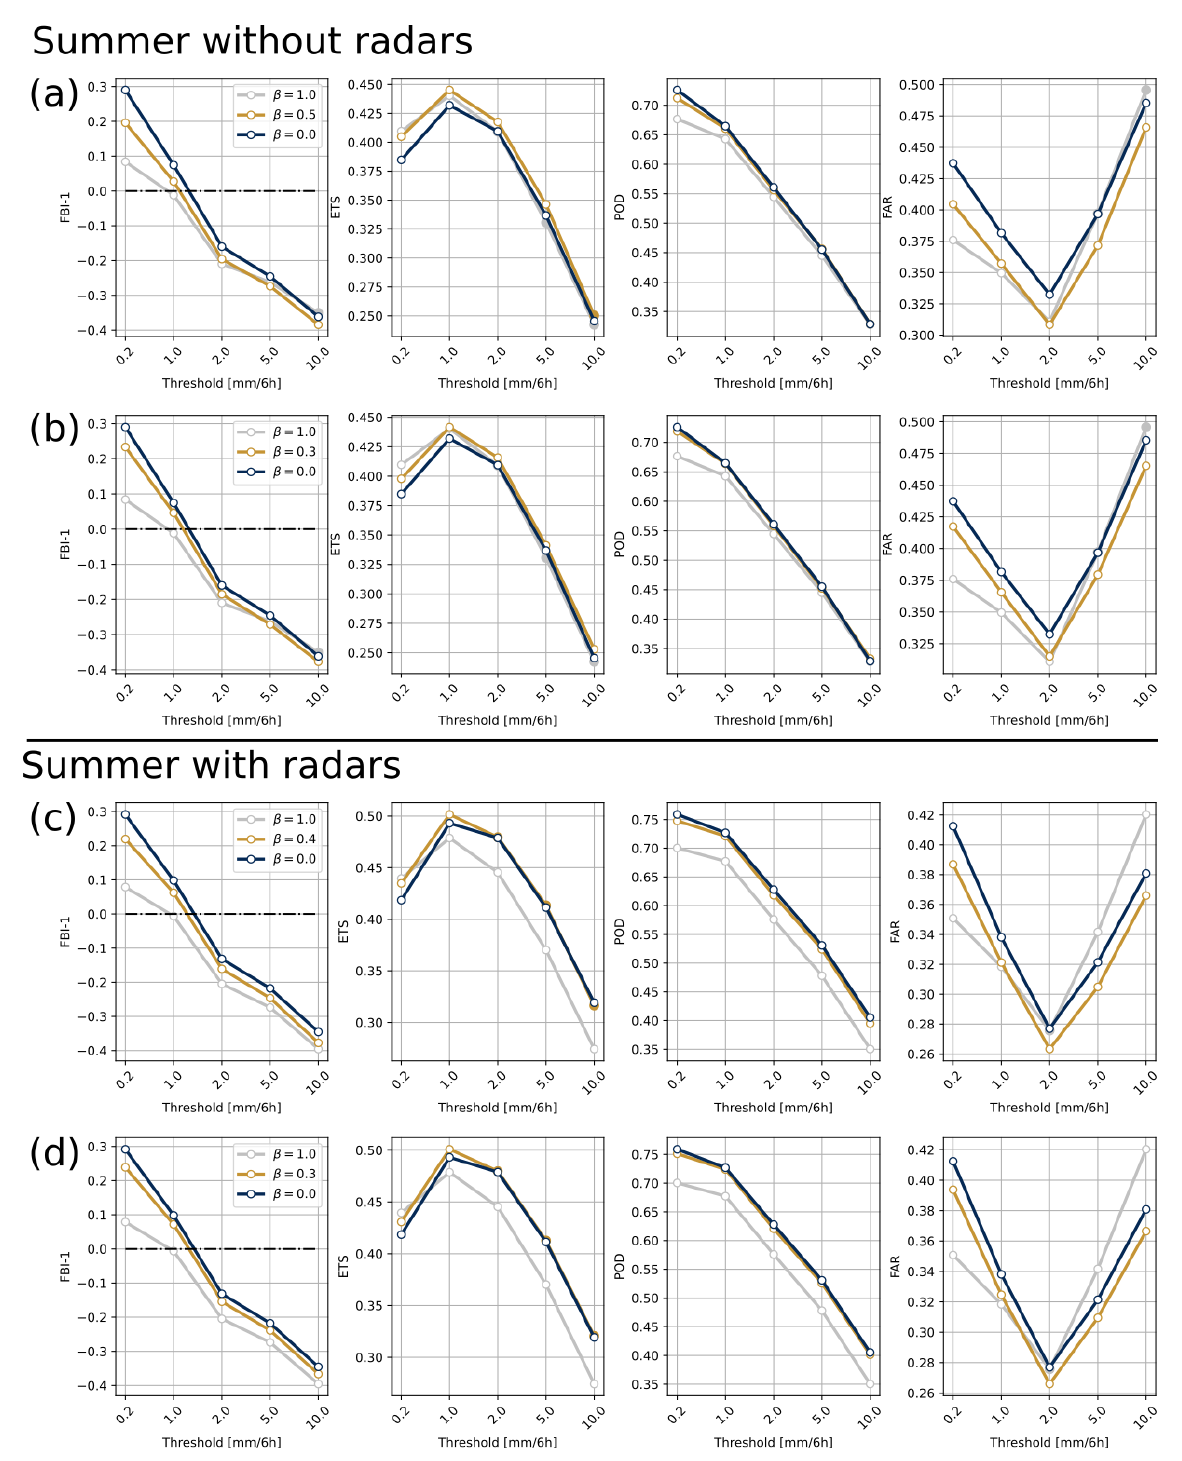
Figure 3. Panels (a) and (b) show the FBI-1, ETS, POD, and FAR across the whole domain for the summer experiment without radar QPEs for precipitation analysis with β = 0 . 0 (dark blue line), β = 1 . 0 (gray line), β = 0 . 5 (yellow lines in a ), and β = 0 . 3 (yellow lines in b ). Panels (c) and (d) are the same figures but for the summer experiment with the assimilation of radar QPEs with β = 1 . 0 (gray lines), β = 0 . 4 (yellow lines in c ), and β = 0 . 3 (yellow lines in d ), with all three compared to the reference experiment when β = 0 . 0 (blue lines). Filled markers indicate no significant differences (at the 95% confidence level) between the reference experiment β = 0 . 0 and the β = 1 . 0, β = 0 . 5, β = 0 . 4, or β = 0 . 3